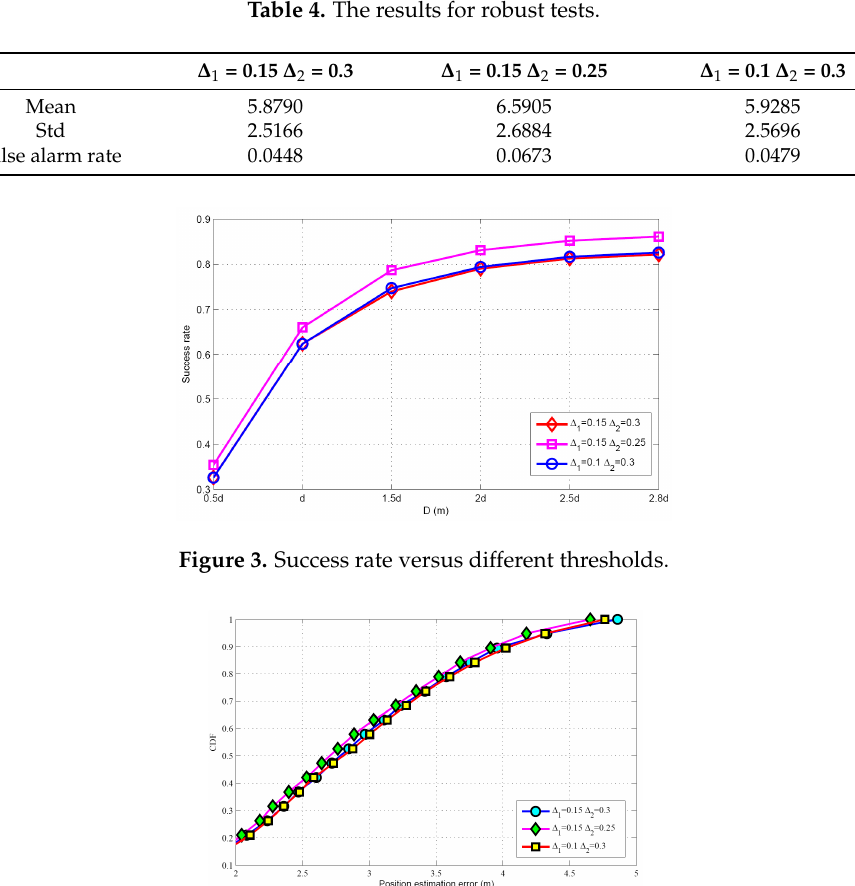
Figure 4. CDF versus different thresholds.